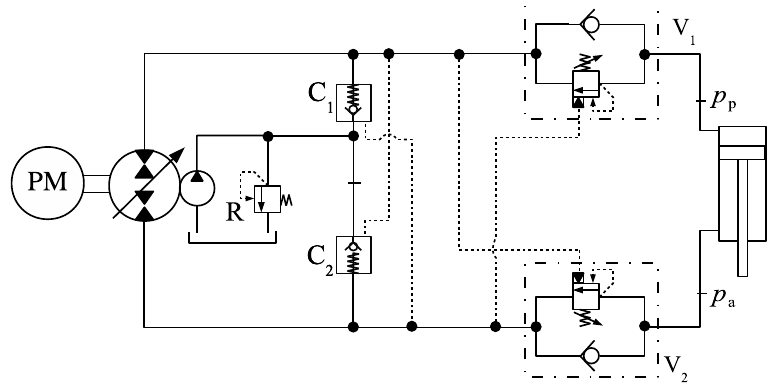
Figure 17. Counterbalance valves in the circuit.